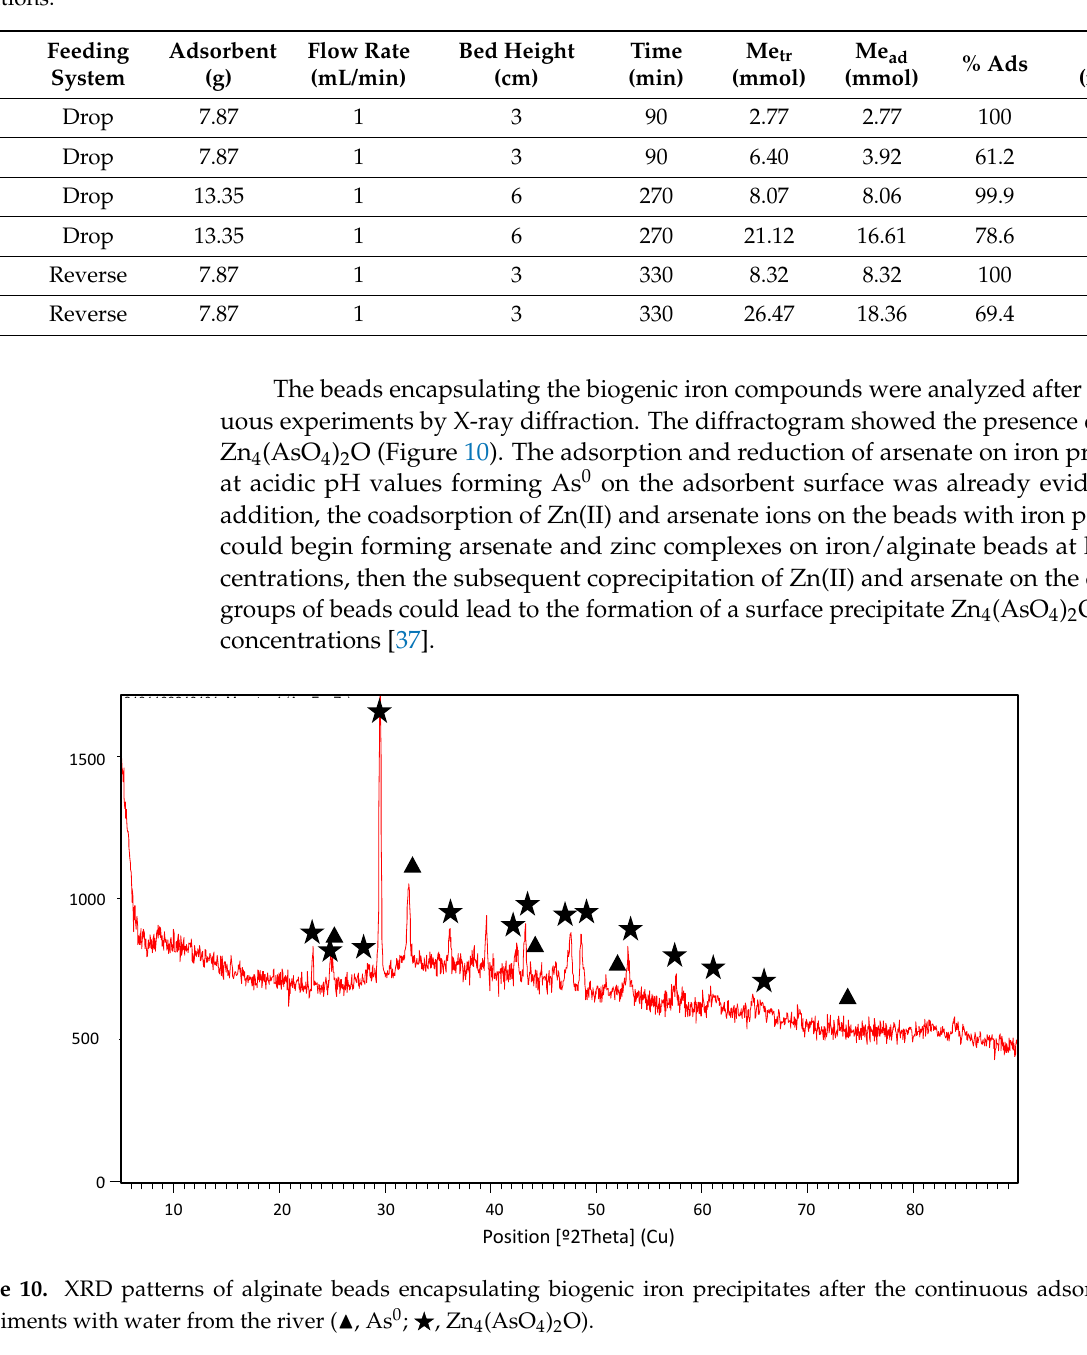
Table 4. Arsenic and zinc adsorption in columns charged with encapsulated biogenic iron under different experimental conditions.